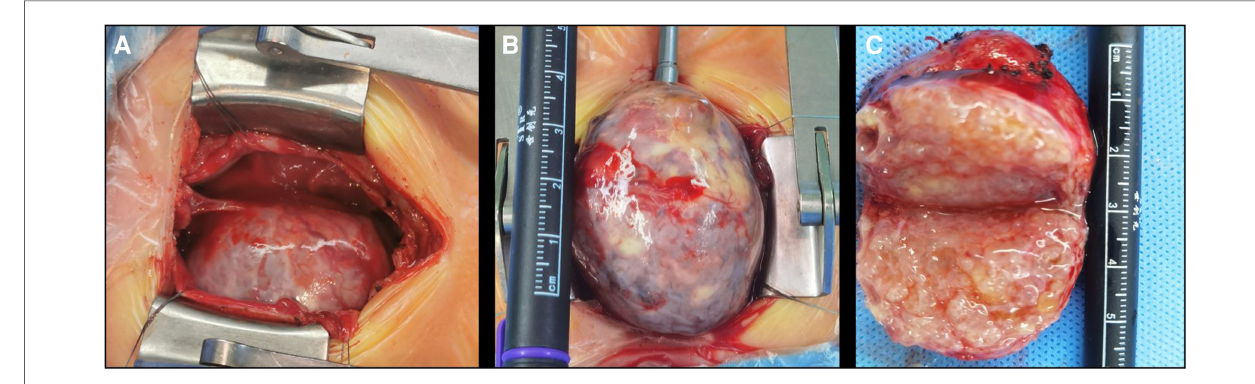
FIGURE 4 Intraoperative view. ( A ) The appearance of a mass after thoracotomy; ( B ) the appearance of a partially free mass placed outside the thoracic cavity; and ( C ) polycystic fat in the cross section after dissection of the